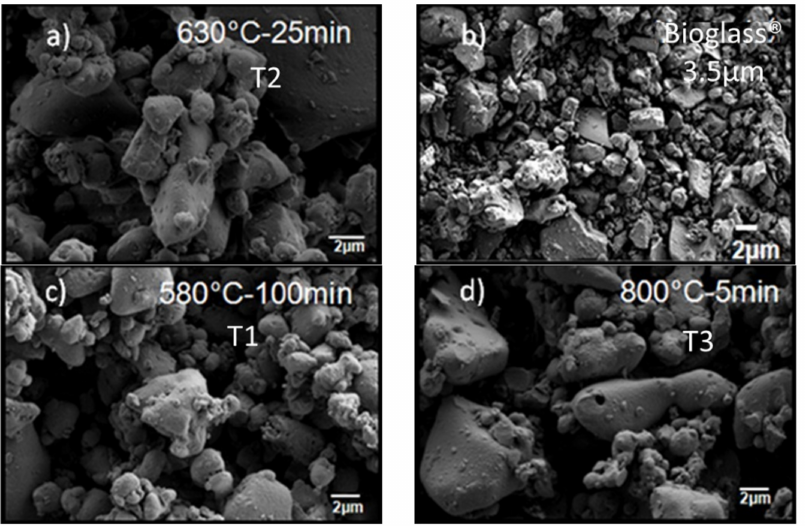
Figure 2. Scanning electron micrograph of the Bioglass ® particles, as-ground ( b ) and after thermal treatment ( a ) T2, ( c ) T1 and ( d ) T3.